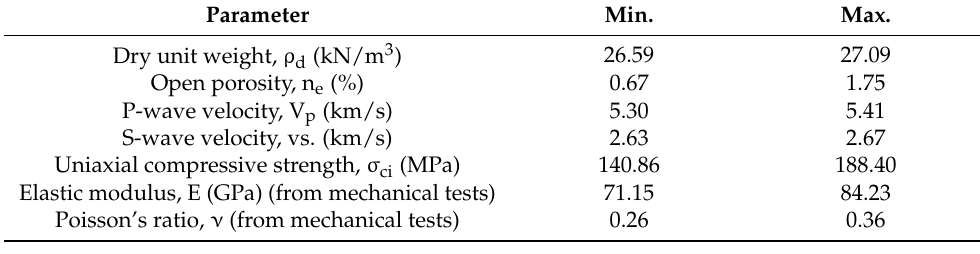
Table 1. Reference values for intact samples heated at 105 °C.